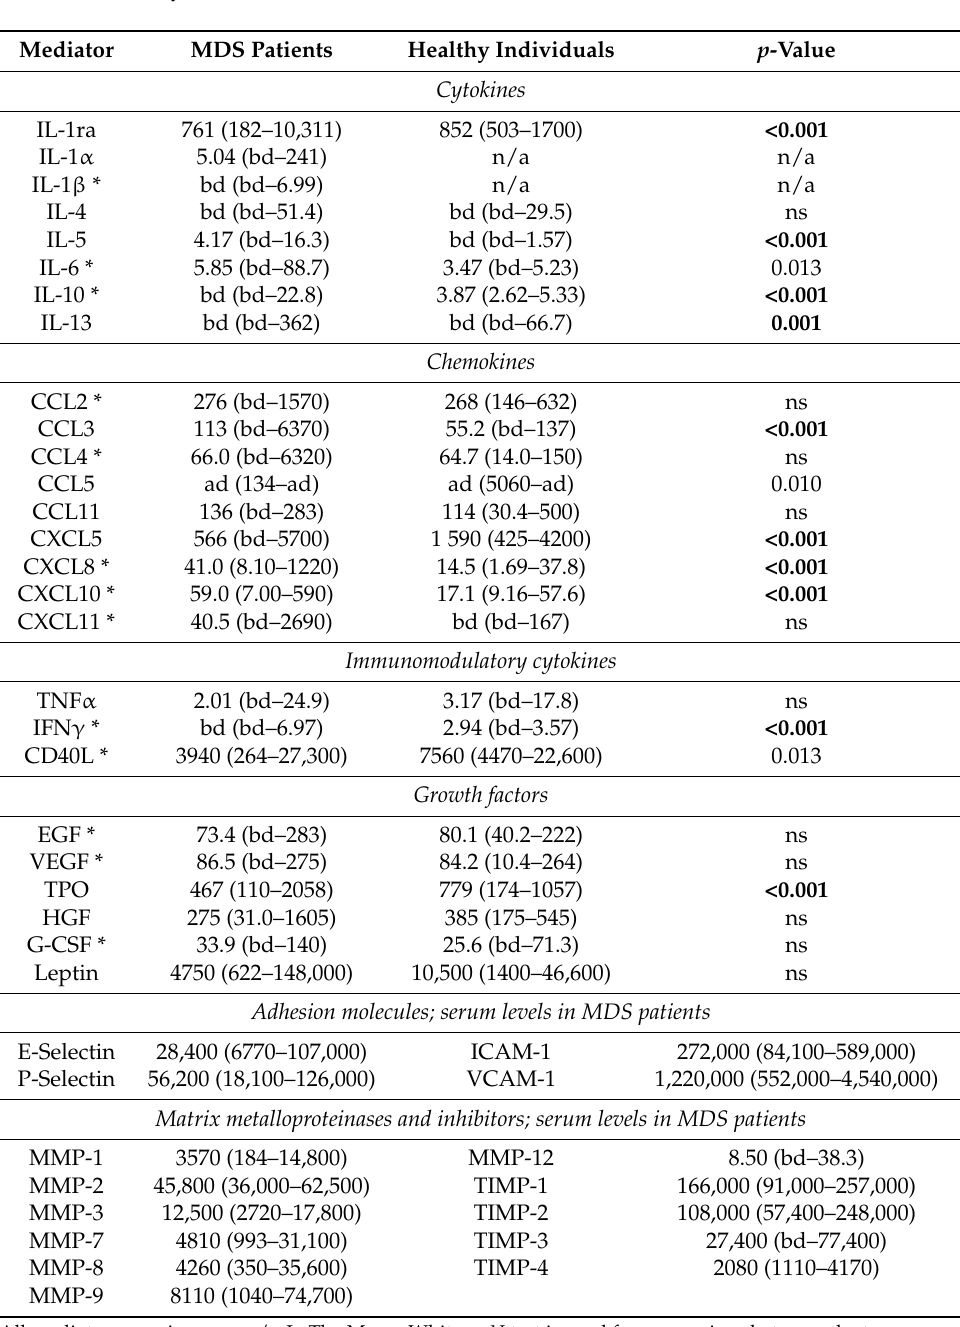
Table 1. Serum levels of soluble mediators; a comparison between myelodysplastic syndromes (MDS) patients and healthy